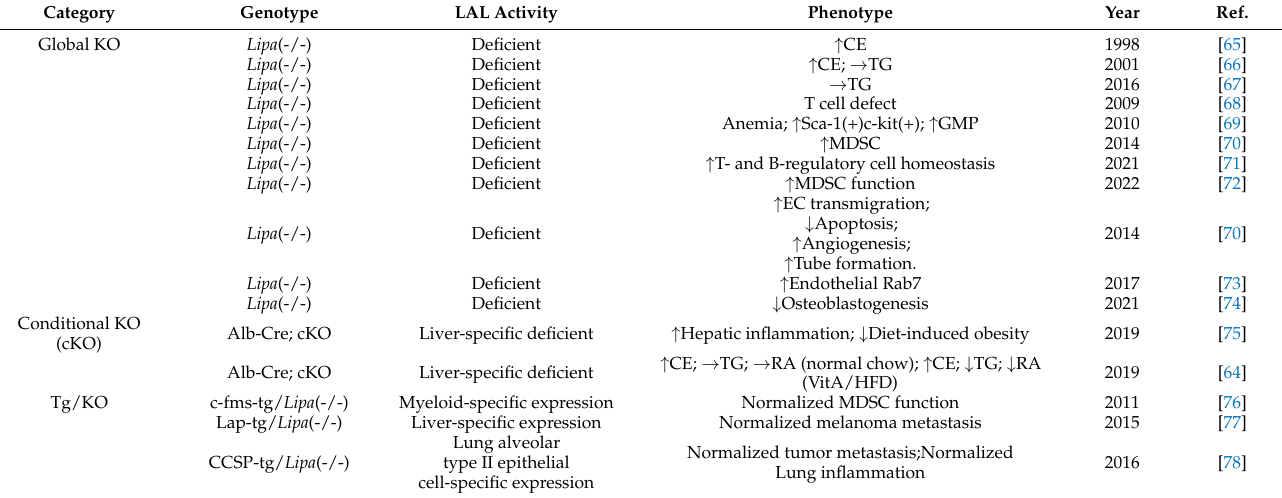
Table 4. Phenotype of Lipa -deficient